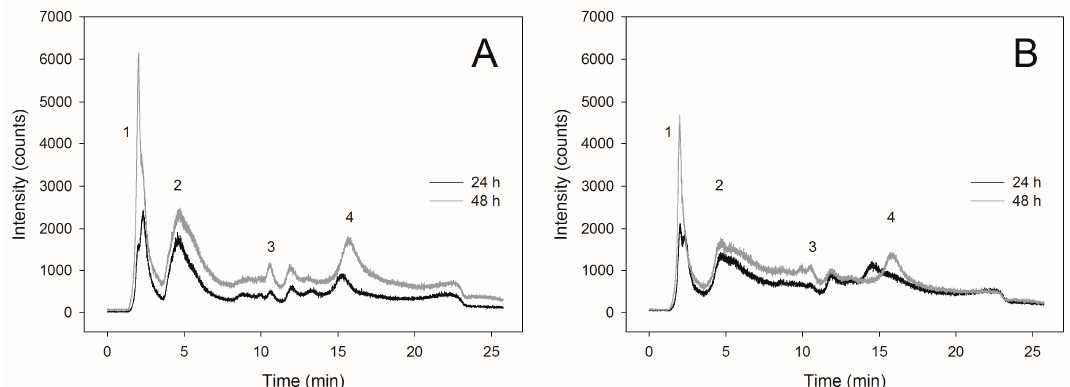
Figure 3. Chromatograms of selenium compounds separation obtained from Candida utilis ATCC 9950 yeasts biomass during 24- and 48-h culture on experimental media enriched with selenium at a concentration of ( A ) 20 mg · L − 1 and ( B ) 30 mg · L − 1 . The retention times were as follows: (1) seleno-methyl-selenocysteine, SeMetSeCys = 2.8 min, (2) selenomethionine, SeMet = 4.6 min, (3) γ -glutamyl-seleno-methyl-selenocysteine, γ -glutamyl–SeMetSeCys = 9.9 min, (4) selenite, Se(IV) = 14, (5) selenite, Se(VI) = 17.4 min.